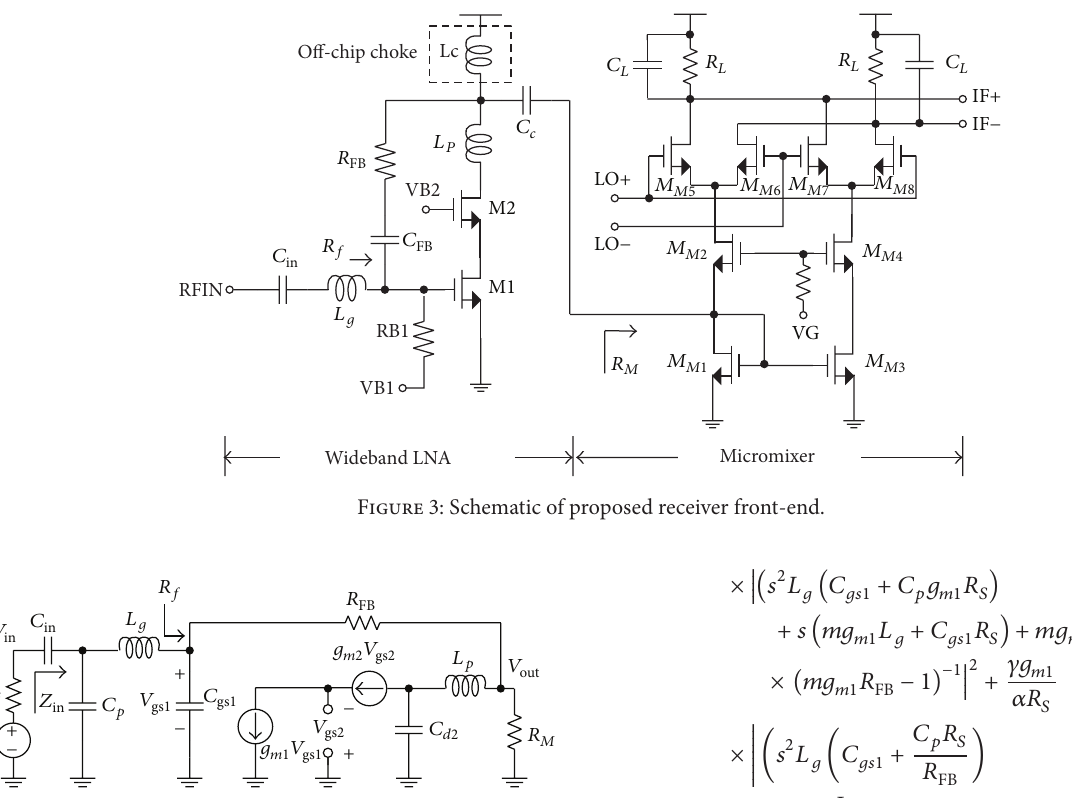
Figure 4: Small-signal model of wideband